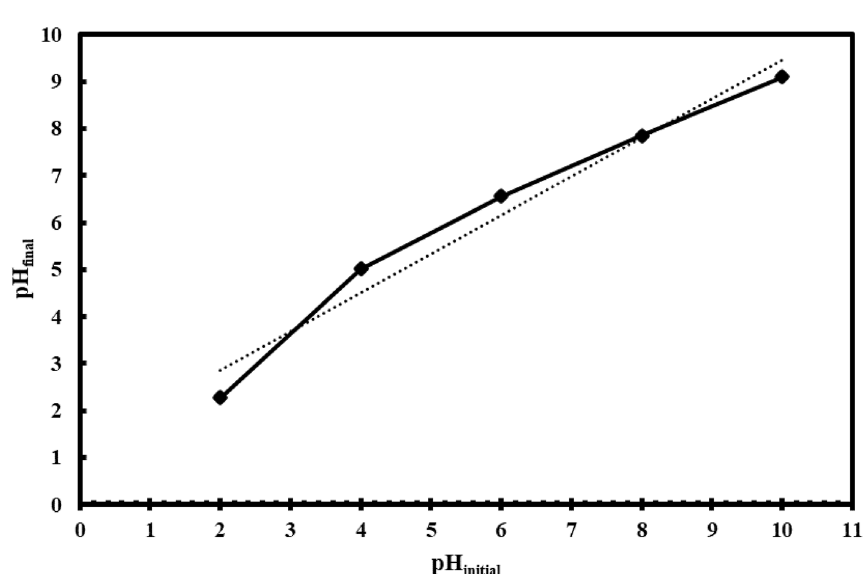
Figure 7. Zero point of charge of Fe 3 O 4 @MOF-PAMAM at various pH